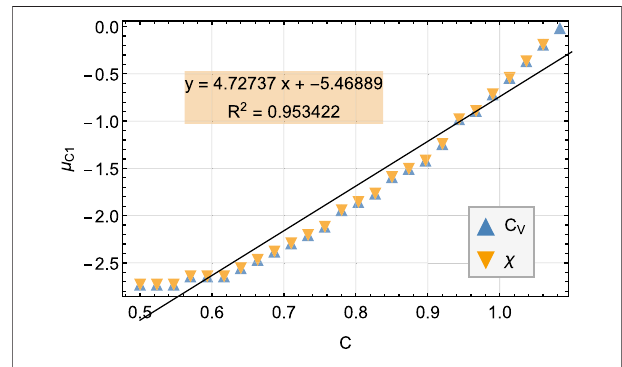
FIGURE 5 | μ c 1 as function of C taken from both C V and χ . Values of μ c 1 concide for both variables at all the values of C . The linear fi t was performed jointly for both